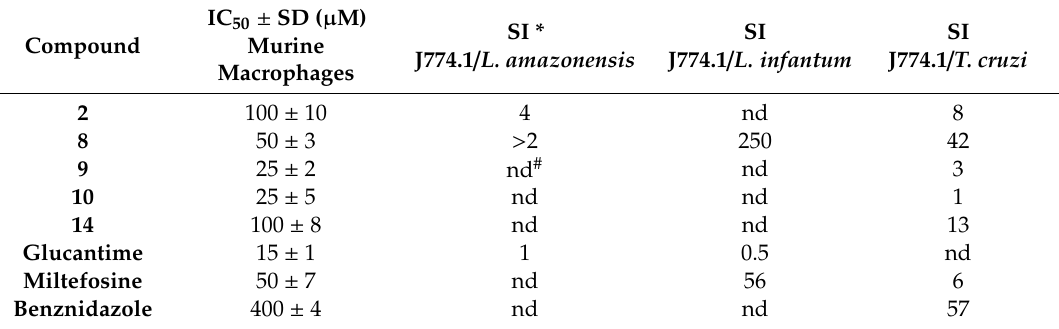
Table 2. Nonspecific cytotoxicity test was carried out with J774.1 murine macrophages and selectivity indexes were calculated for L. amazonensis (promastigotes), L. infantum (promastigotes), and T. cruzi (epimastigotes).